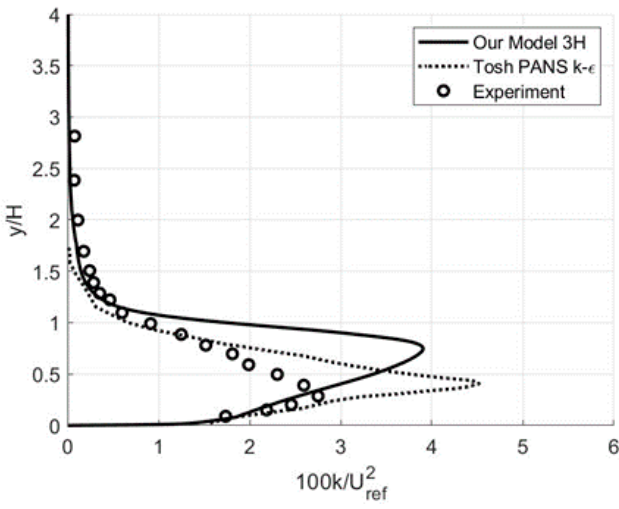
Figure 9. Mean kinetic energy profiles at x / H = 5 from the step ( f ε = 0.667, f k = 0.2 ) .